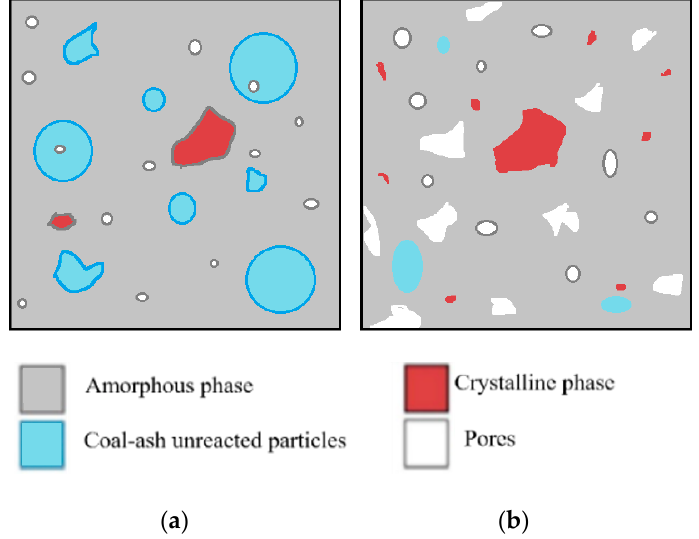
Figure 5. Schematic representation of geopolymers morphology: ( a ) after setting time ending and ( b ) after reacting [36].